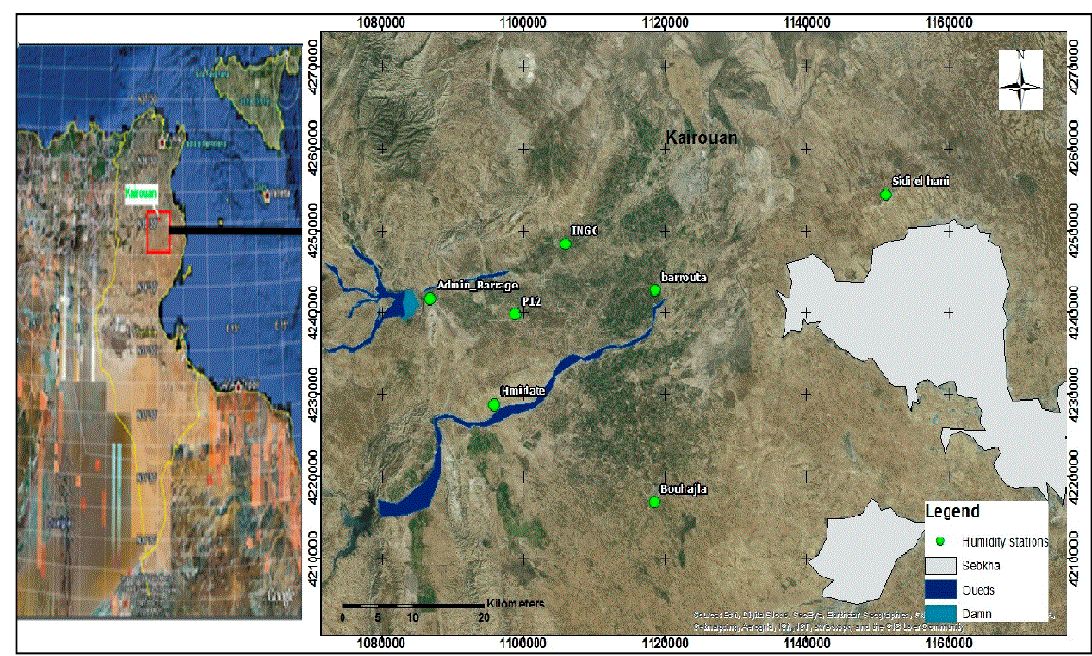
Figure 1. Location of the study site in Tunisia.